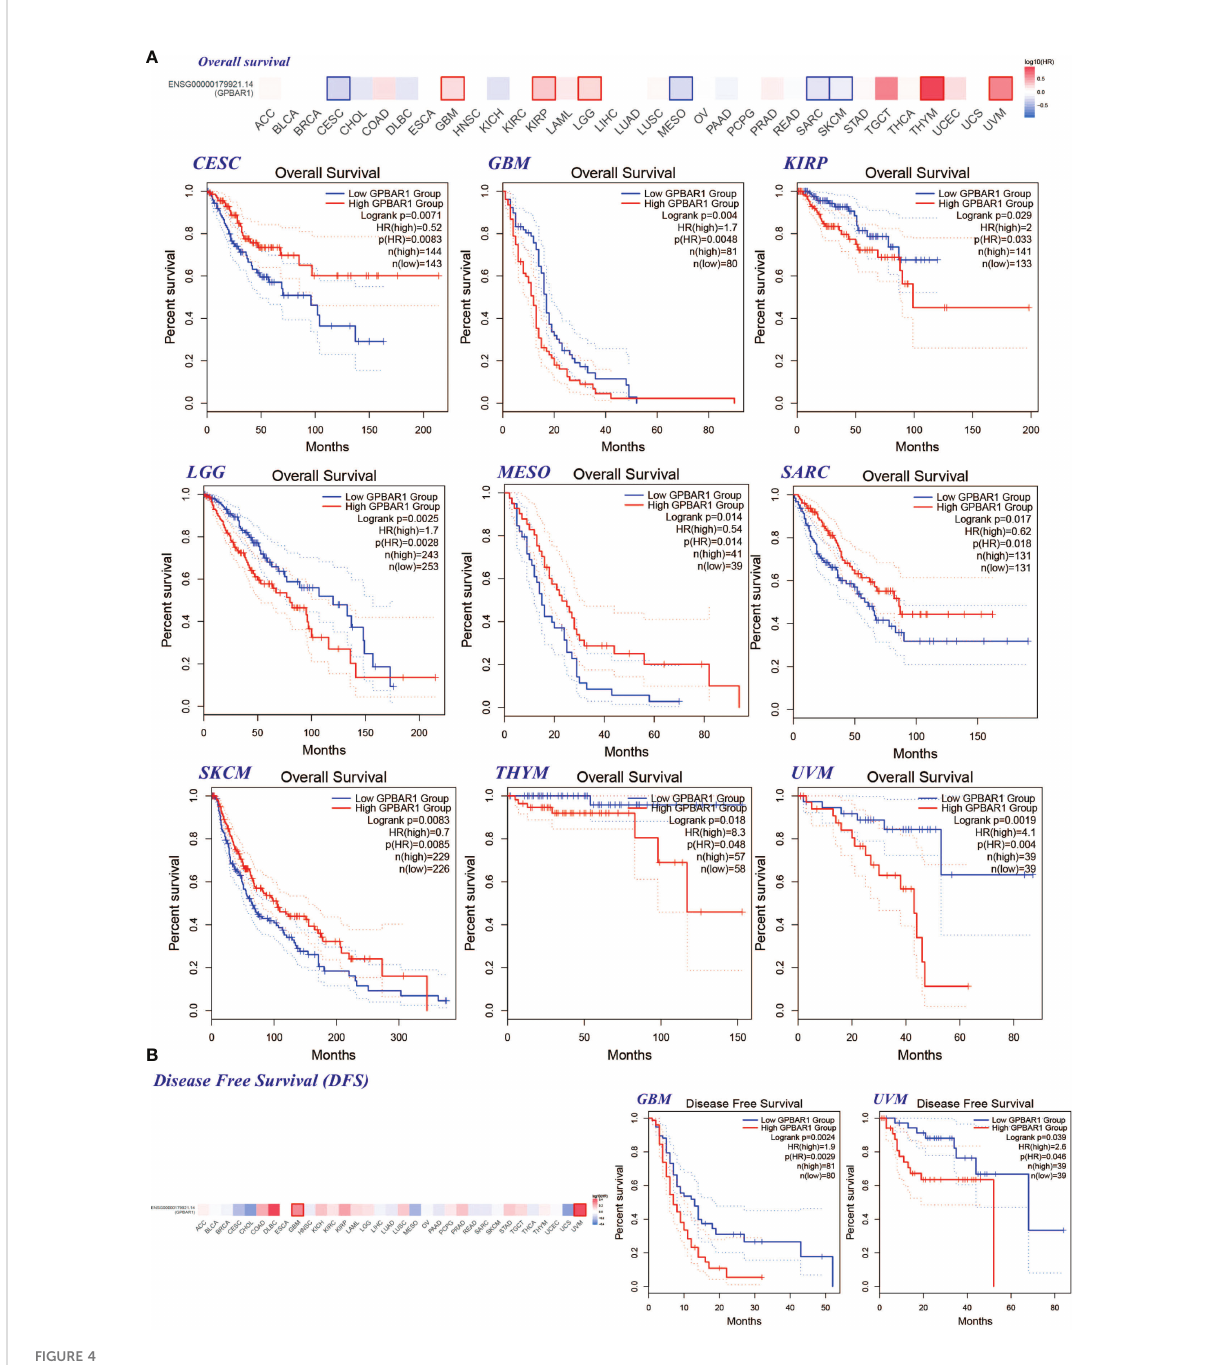
FIGURE 4 The correlation between the TGR5 gene expression level and patient survival in all TCGA tumors. (A) Overall survival in CESC, GBM, KIRP, LGG, MESO, SARC, SKCM, THYM, and UVM. (B) The GEPIA2 instrument is used to analyze the survival rate of GBM and UVM. This fi gure shows the survival plot and Kaplan – Meyer curve with positive